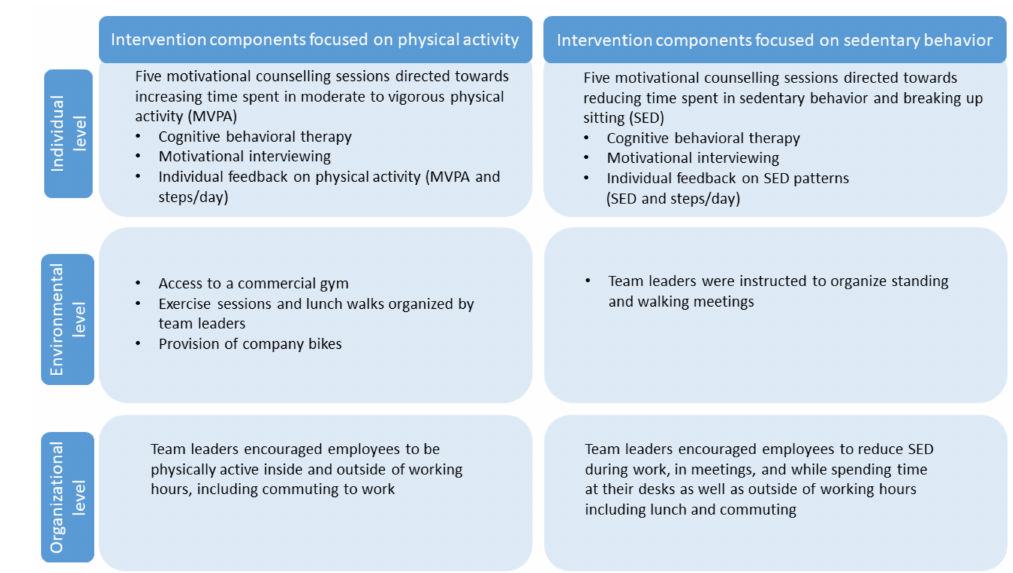
Figure 2. Overview of the intervention design showing which components were addressing the individual, environmental and organizational